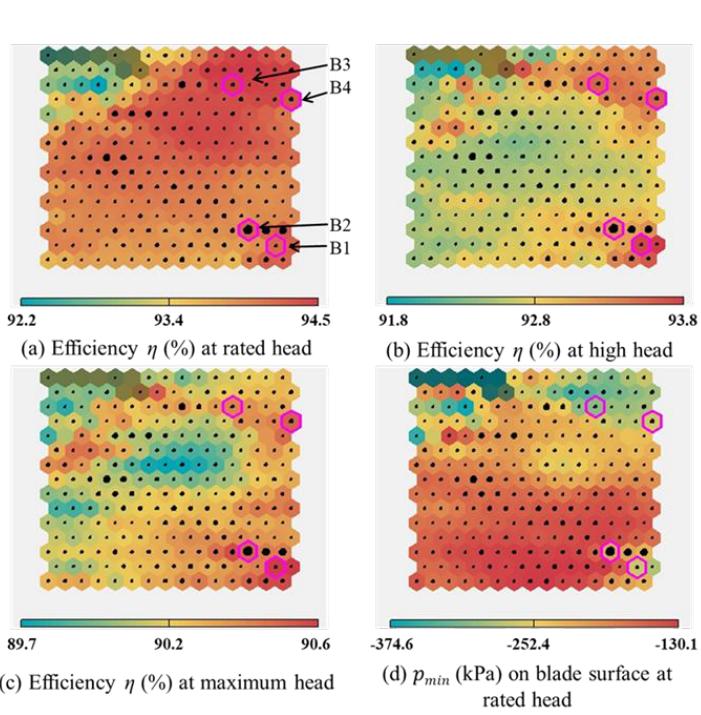
Figure 9. The optimized two-dimensional SOMs. Table 6. Optimized parameters by the second step optimization.